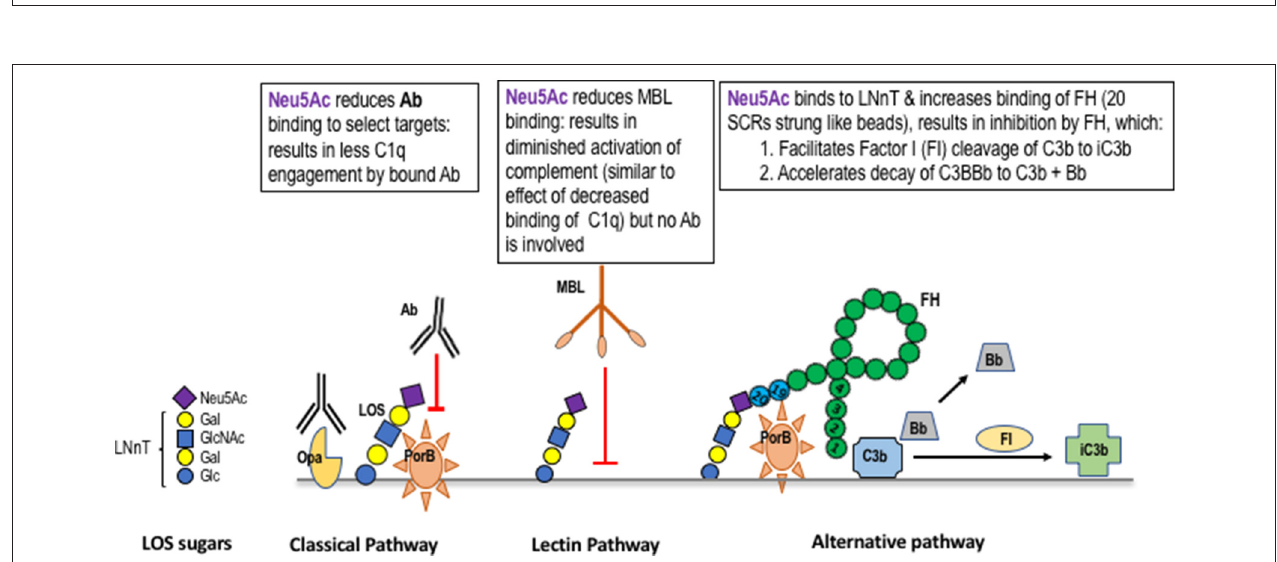
FIGURE 2 | Mechanisms of complement regulation by sialic acid on gonococcal lacto- N -neotetraose (LNnT). Gonococci can add N-acetylneuraminic acid (Neu5Ac; the form of sialic acid found in humans) to the terminal Gal of the lacto- N -neotetraose (LNnT) LOS structure (a schematic of sialylated LNnT is shown on the left side of the Figure). The presence of Neu5Ac on LNnT LOS reduces the binding of IgG to select targets. As an example, binding of mAbs to PorB, but not to Opacity protein (Opa), is inhibited (79). Sialylation of LNnT also inhibits binding of “natural” IgG in NHS to the gonococcal surface (80). Binding of mannan binding lectin (MBL) to the surface of gonococci is inhibited by LNnT LOS sialylation (81). MBL binds to gonococcal LOS that terminates in GlcNAc (82), which is elongated (“capped”) by Gal and Neu5Ac (shown on the left side of the Figure) and to Opa and PorB (83) [Opa and PorB (shown in the Classical Pathway frame to the left of the Lectin Pathway frame in the Figure)]. Neu5Ac that caps LNnT also regulates the alternative pathway of complement by enhancing binding of factor H (FH; shown as a “string of beads” in the Alternative Pathway frame) (40). Enhanced FH binding to sialylated gonococci is restricted to the LNnT structure; sialylation of the P k -like LOS (84), or lactose on HepII (78) does not enhance FH binding. Binding of FH is also dependent on expression of PorB (85) and occurs through the C-terminal domains of FH (SCR18-20) (86). Bound FH acts as a cofactor in the factor I (FI) cleavage of C3b to iC3b (cofactor activity) and also irreversibly dissociates the C3 convertase, C3bBb (decay accelerating